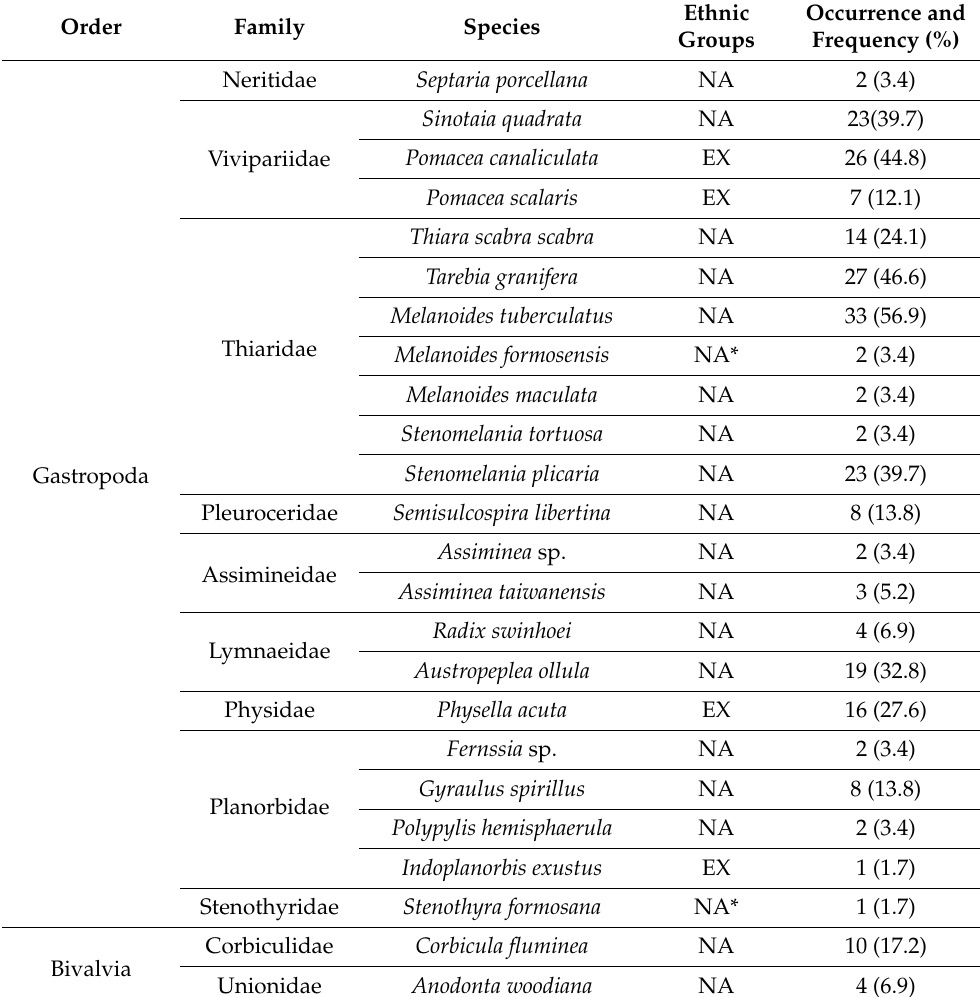
Table 5. The occurrence and frequency of recorded gastropods and bivalves in the 58 sampled springs of Taiwan (Ethnic groups: Exotic species (EX)/Native species (NA)/Endemic species (NA*)).